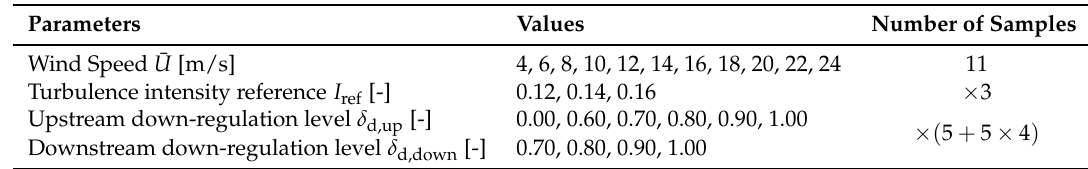
Table 1. Input variables for surrogate models.